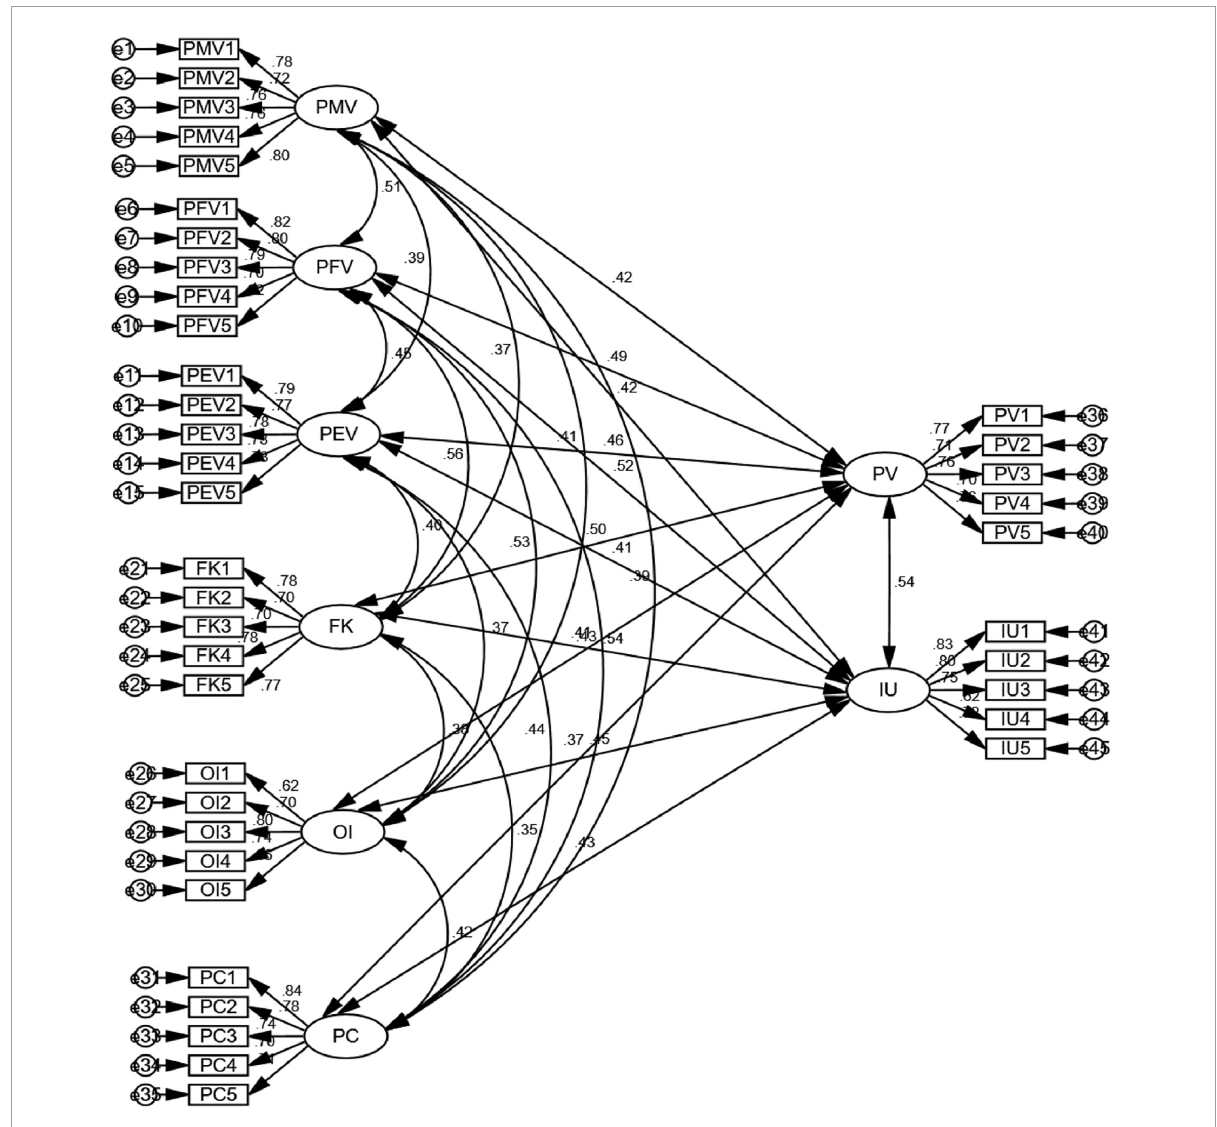
FIGURE2 Diagram illustrating the measurement